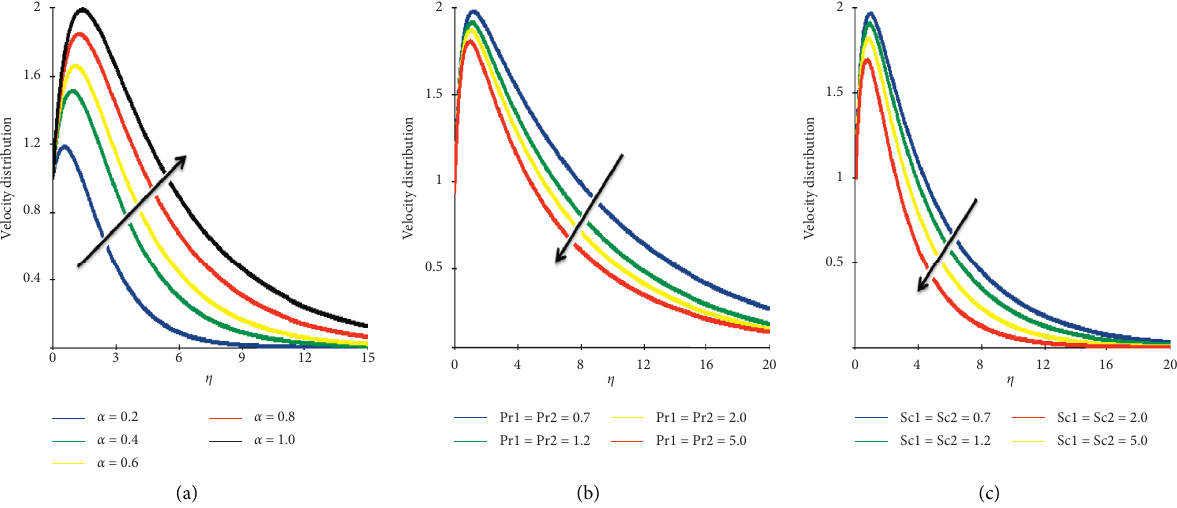
Figure 6: Sketch velocity profile for changing α , Pr, and Sc.